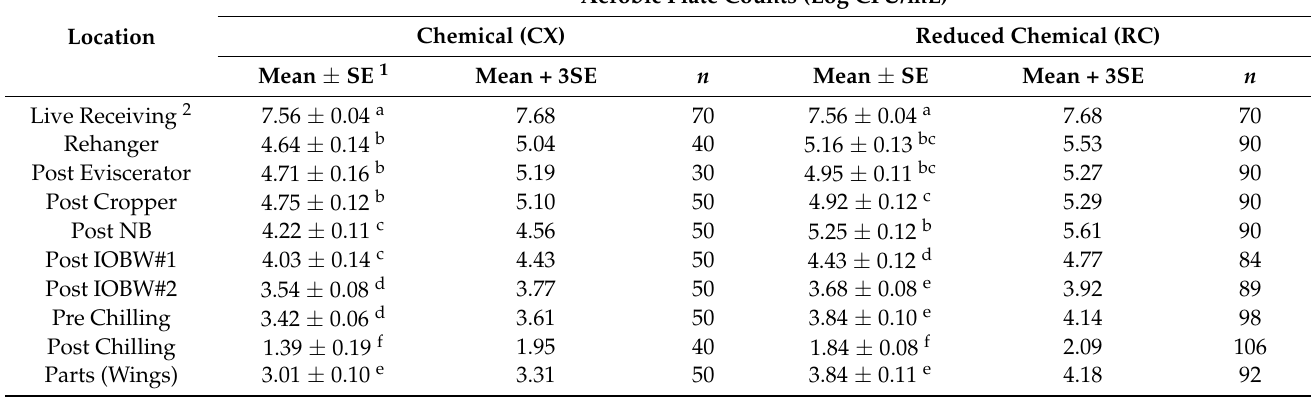
Table 1. Aerobic plate counts (log CFU/mL) on each of the ten locations during the evisceration process under normal process interventions (CX) and low-chemical process interventions (RC) on chicken